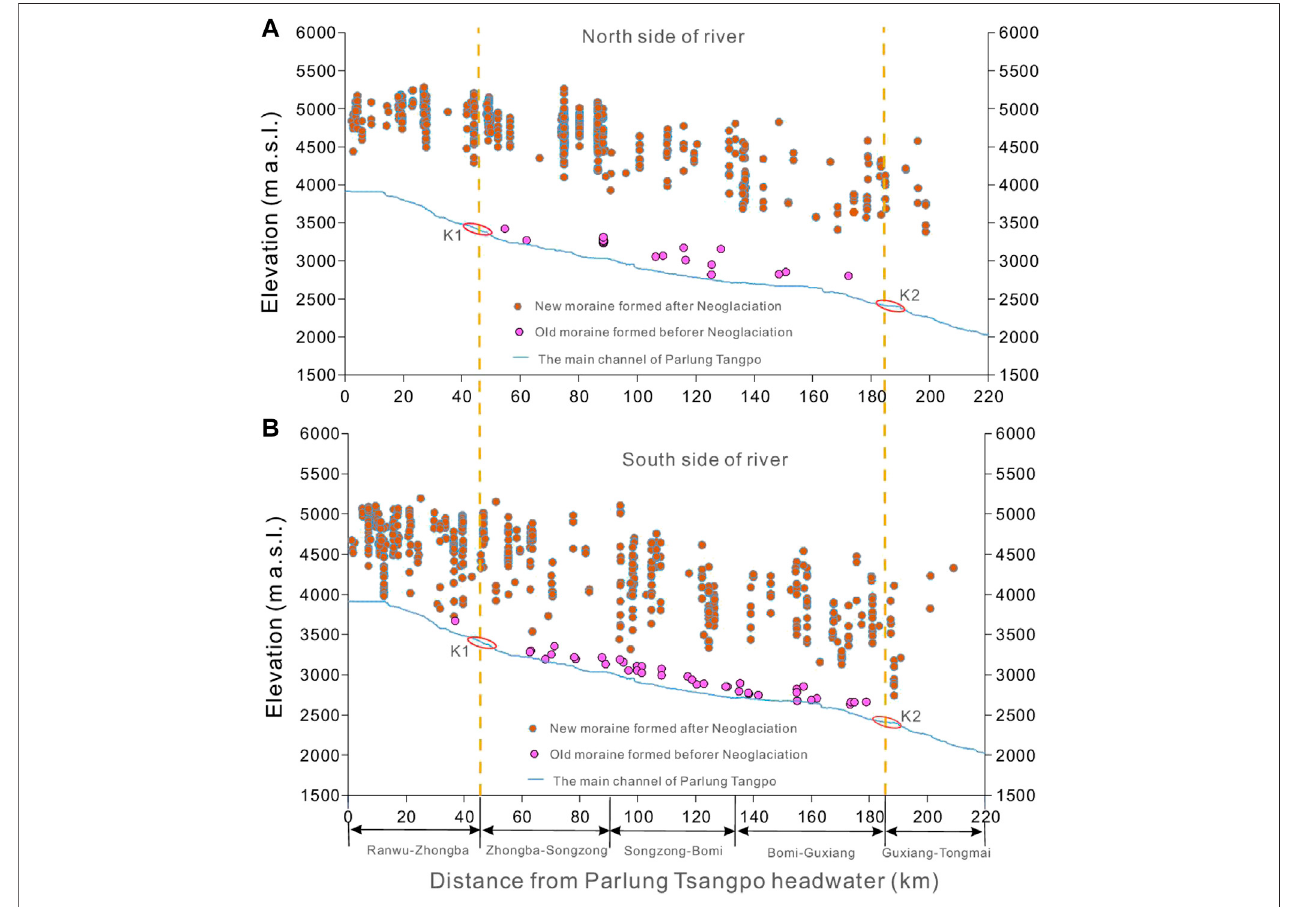
FIGURE 9 | Distribution characteristic of moraine along the Parlung Tsangpo river. ( (A) Moraine distribution in the north side of river. (B) Moraine distribution in the south side of river).